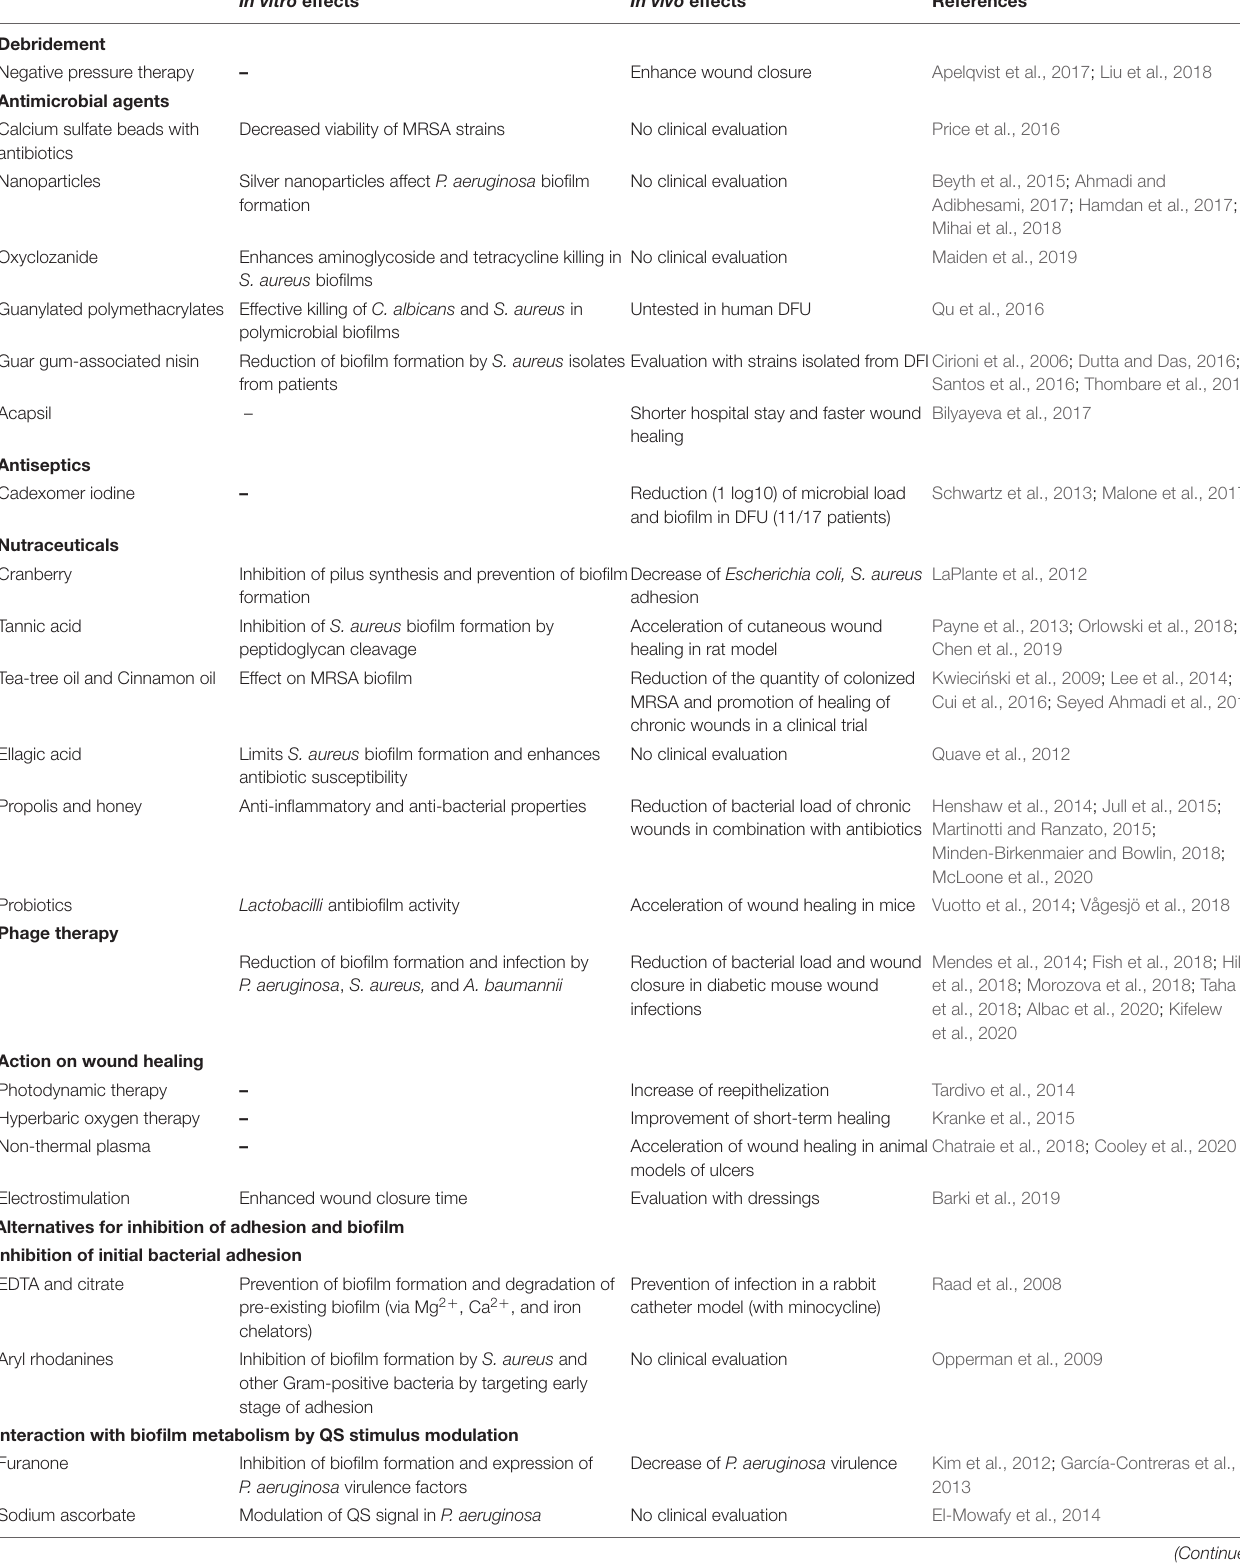
TABLE 1 | In vitro and in vivo effects of the main alternative approaches